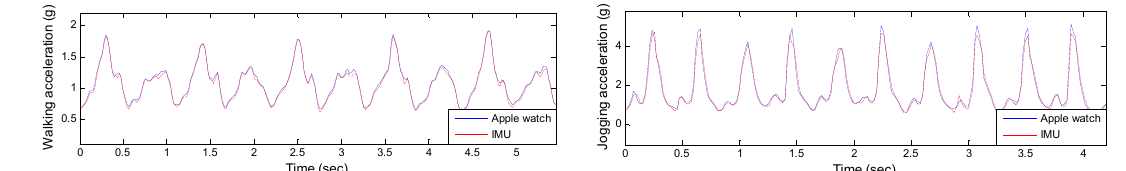
Figure 1. Example of 10 steps of raw unfiltered acceleration data for the Apple watch and the inertial monitoring units (IMU). Walking ( left ) and jogging ( right ).